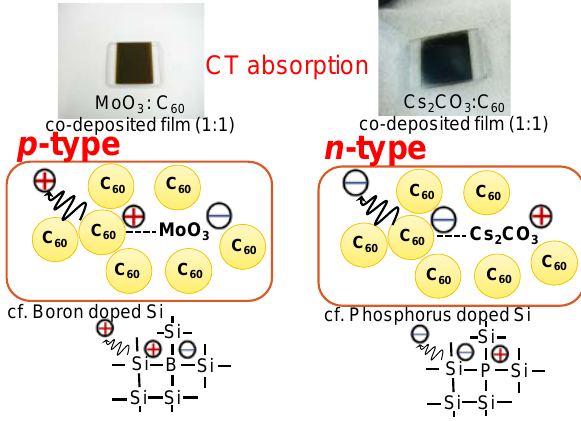
Figure 13. (Upper) Photographs of C :MoO (1:1) (left) and C 60 3 Strong CT-absorption was observed. (Middle) Mechanisms of p - and n -type C by MoO (left) and Cs CO (right) doping. (Lower) Corresponding mechanisms of p - and 3 2 3 n -type Si formation by B (left) and P (right)